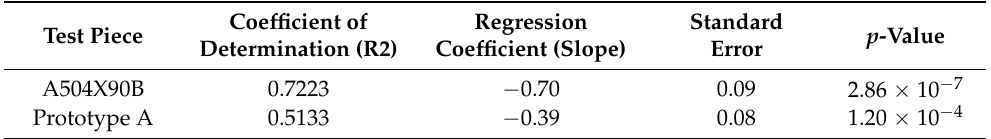
Table 3. Regression analysis